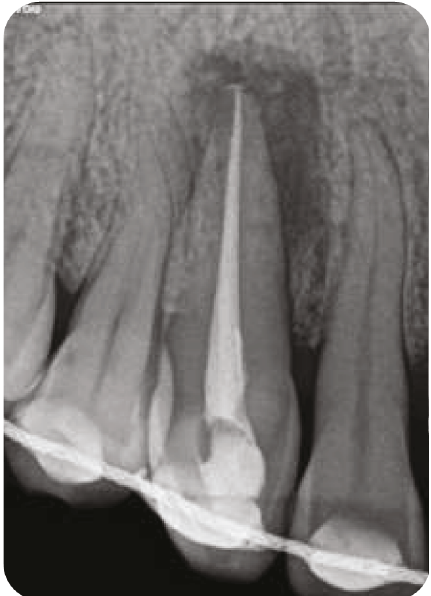
Figure 11: Six months ’ recall radiograph.